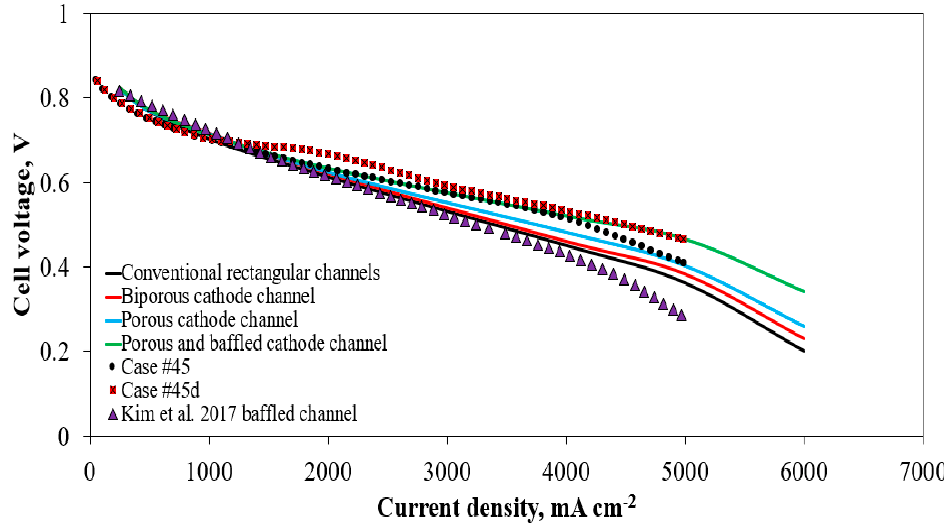
Figure 18. Comparison of polarization curves for different configurations.